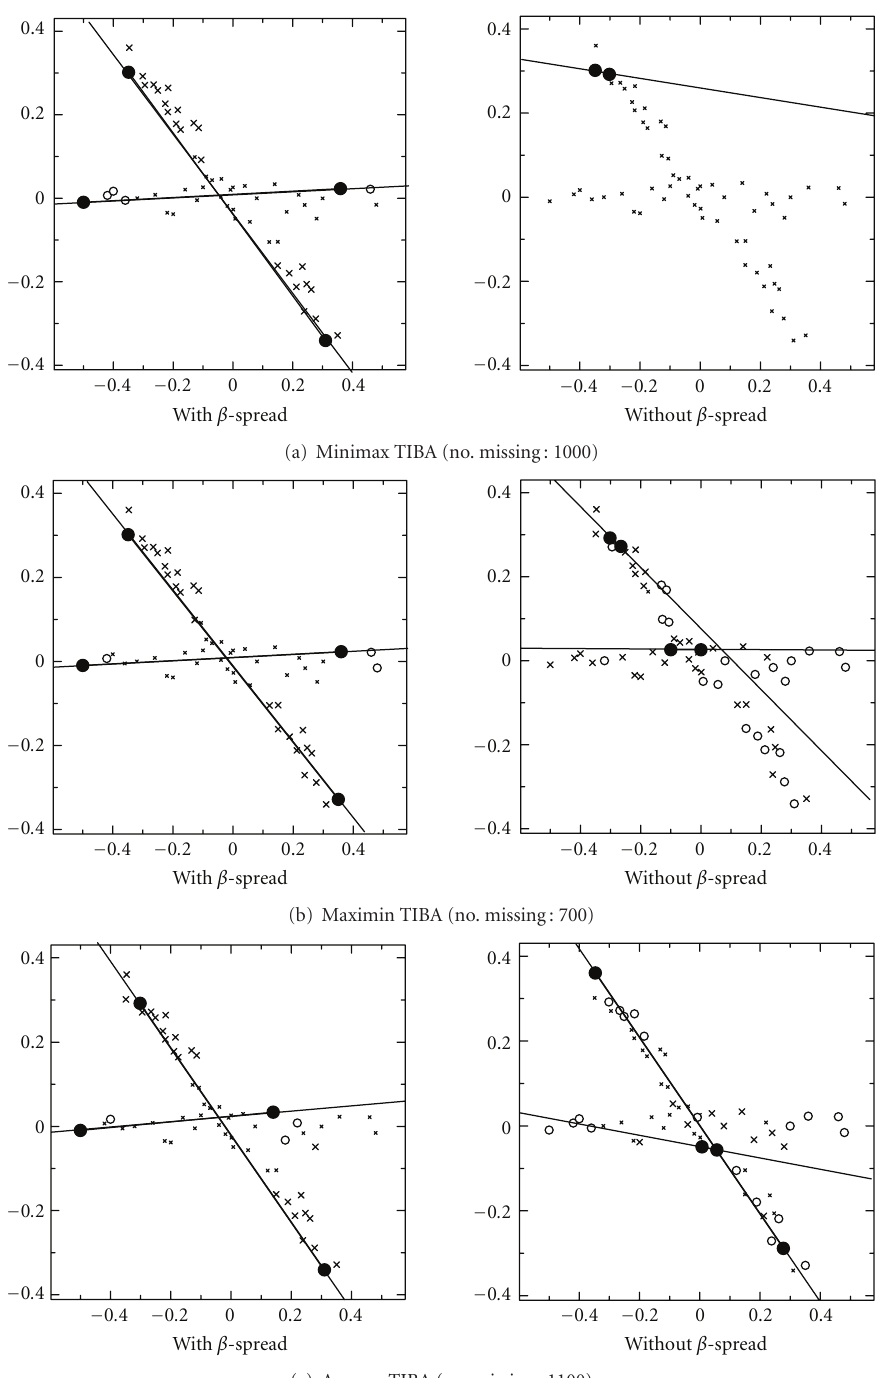
Figure 3: Comparison of cluster partition from relational data imputed by three TIBAs, with (left)/without (right) β -spread transformation ( L 1